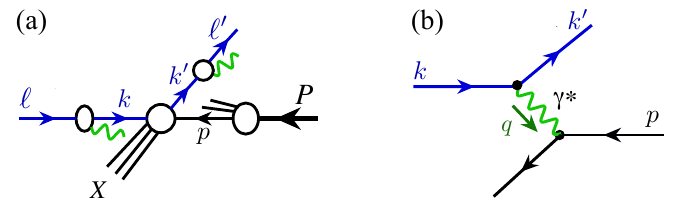
Figure 3 . Sketch of scattering amplitudes for (a) the factorized DIS process in eq. (2.9), and (b) lowest order lepton-quark